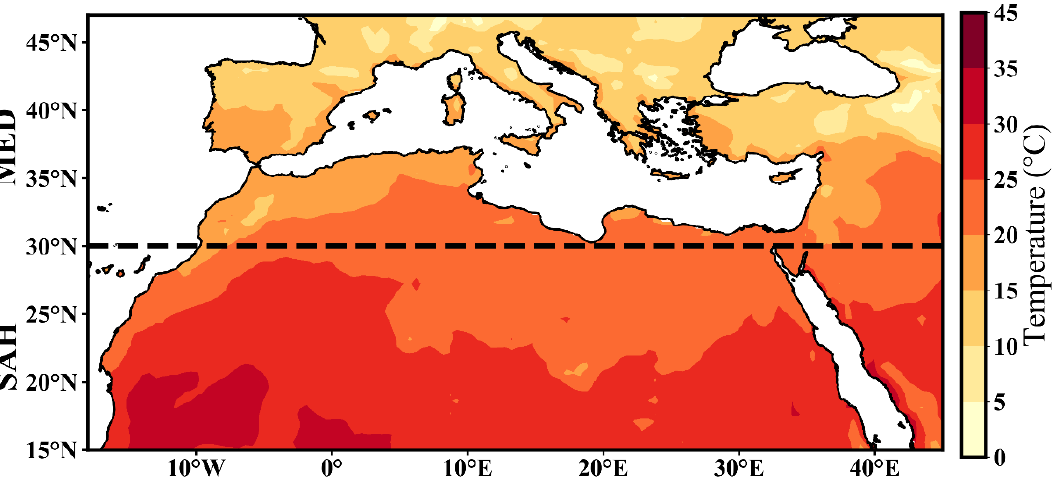
Figure 1. Spatial plot of mean temperature during 1979 to 2014 over the study domain: Mediterranean (MED) and Sahara (SAH), based on the Climate Prediction Centre (CPC). The study region is demarcated (dashed black line) following Iturbide et al. [42].